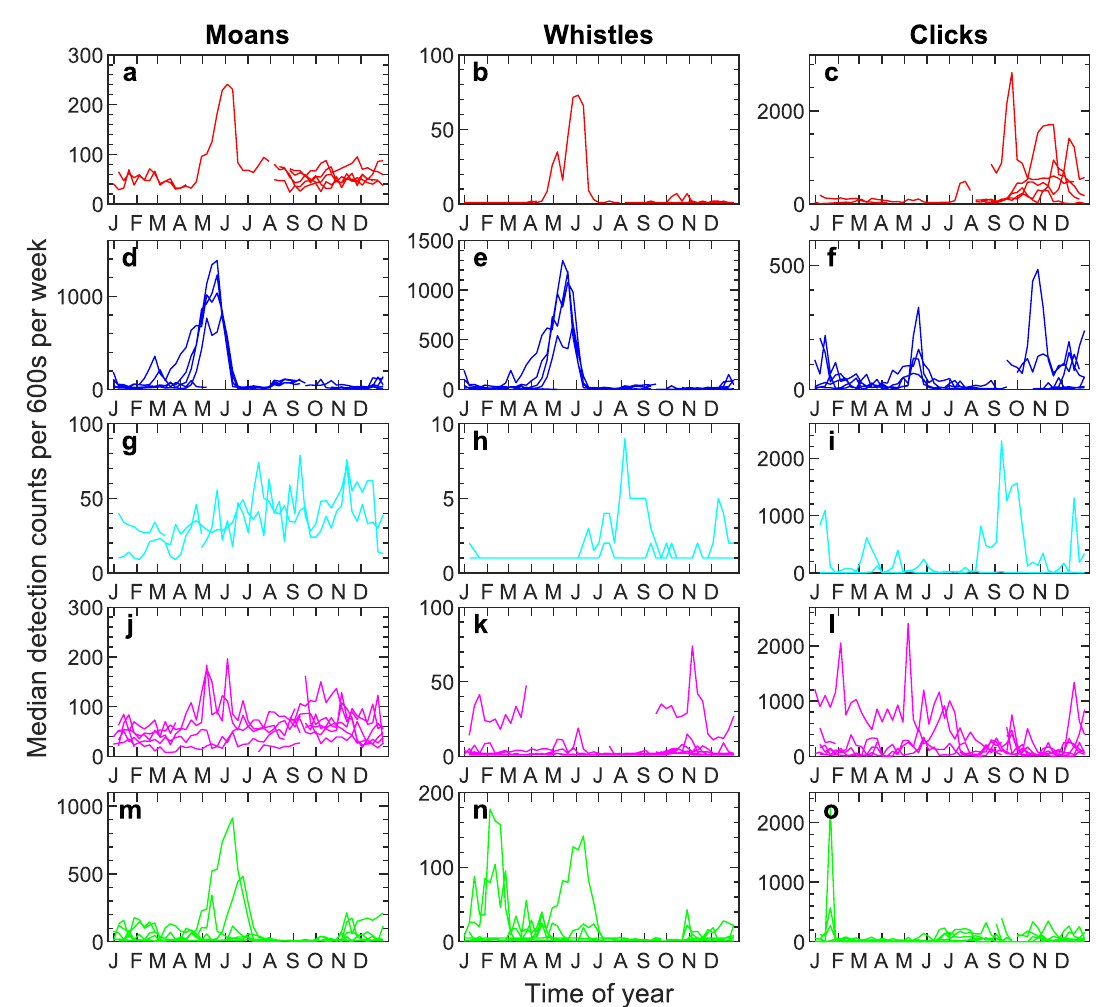
Figure 6. Seasonal and regional (asynchronous) variation of median detection counts. The first column show 0–1500 Hz tonal detector counts (moans). The second column show tonal detector counts (whistles) in the range from 1500 Hz to the Nyquist frequency. The third column show transient detector counts (clicks). The spikes in moans/whistles around May/June are likely bearded seal calls. Note that the variation in these sounds does not correspond to variations in decadal levels in Fig. 5. Region colours as in Fig. 1 (Melville Bay: red, Baffin Bay: blue, South Greenland: cyan, Tasiilaq: magenta, Greenland Sea: